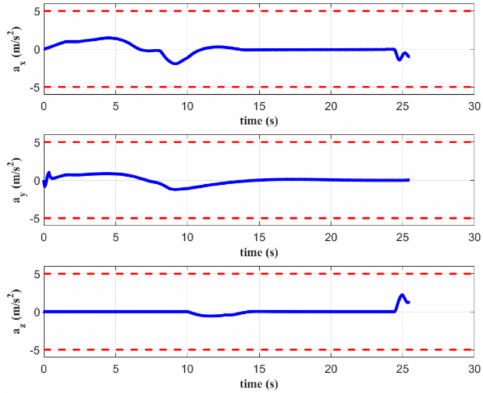
Figure 9. Acceleration of the quadrotor in simulation A.